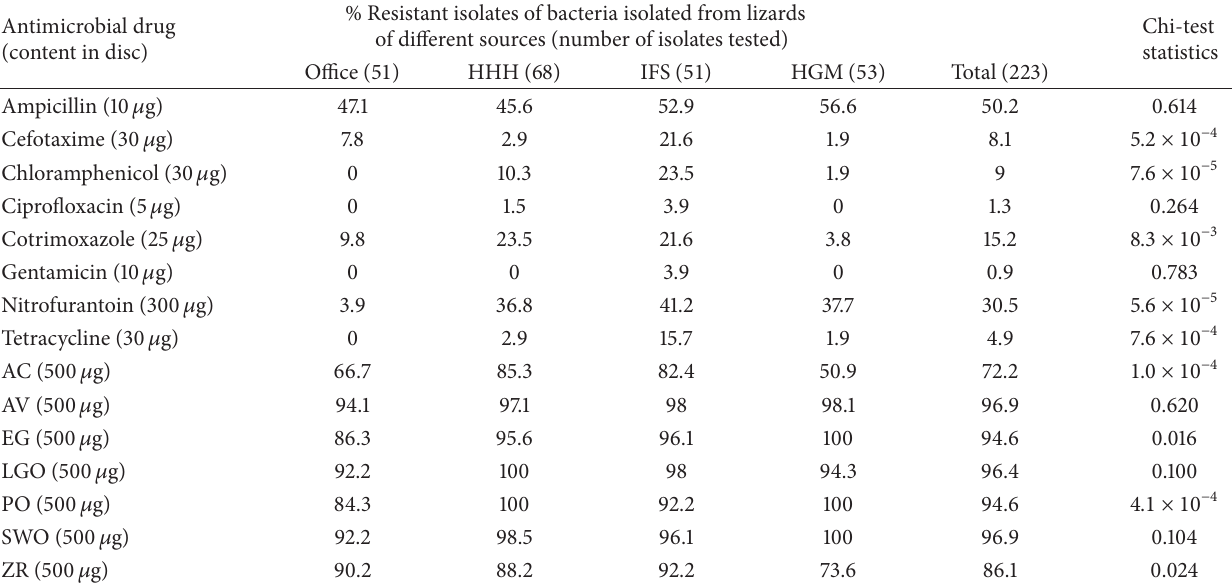
Table 4: Effect of source of geckos on antimicrobial drug resistance (% strains) in bacterial isolates from faecal droppings of geckos. % Resistant isolates of bacteria isolated from lizards Antimicrobial drug of different sources (number of isolates (content in disc)